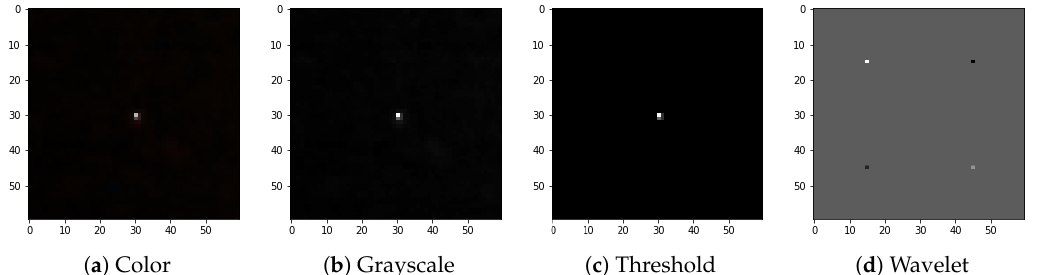
Figure 4. Preprocessing flow: ( a ) color input image, ( b ) grayscale accumulation, ( c ) adaptive thresholding, ( d ) wavelet transformation. Example of the spot-type